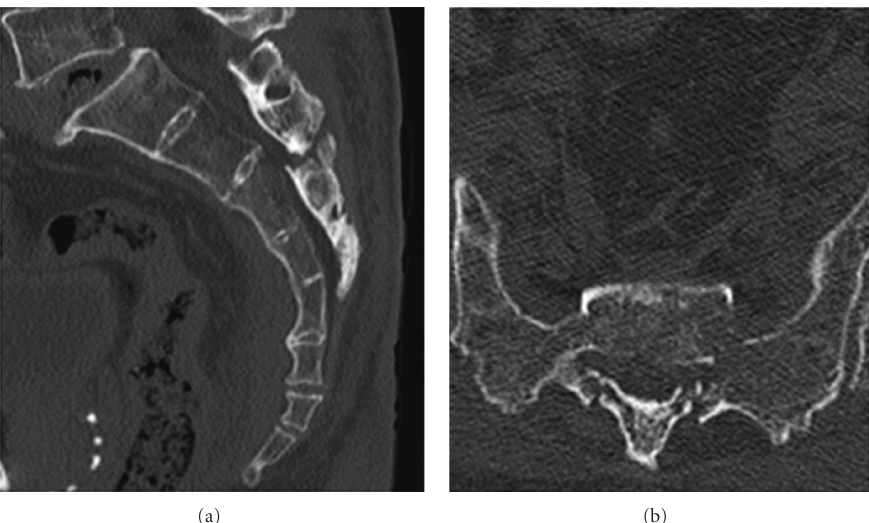
Figure 1: Preoperative reconstructed computed tomogram (CT). (a) Sagittal reconstructed CT: the third sacral lamina fractured and displaced into the spinal canal. The third sacral vertebral body did not angulate. (b) Axial reconstructed CT: the third sacral lamina fractured bilaterally. The spinal canal area decreased. The sacrum was osteoporosis.